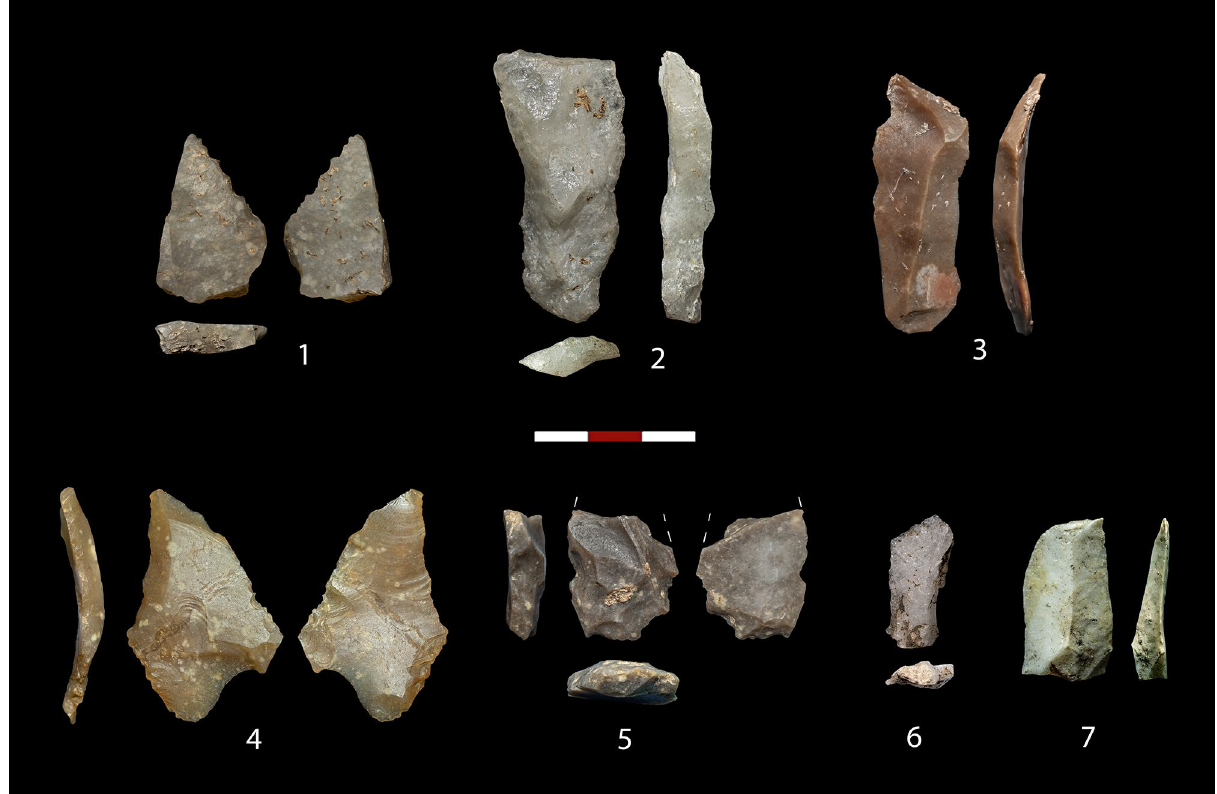
Figure 10. Pre-Solutrean lithic assemblages. Level 4: 1–3. Level 5: 4–5. Level 6: